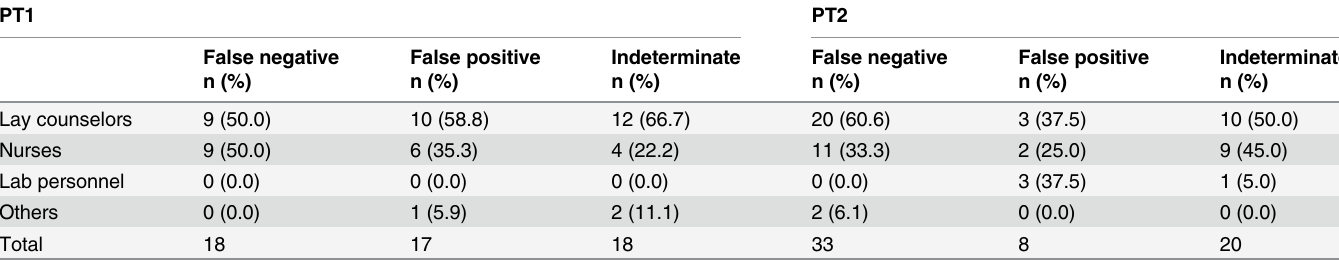
Table 4. Distribution of reported false and indeterminate results by tester profession in PT1 and